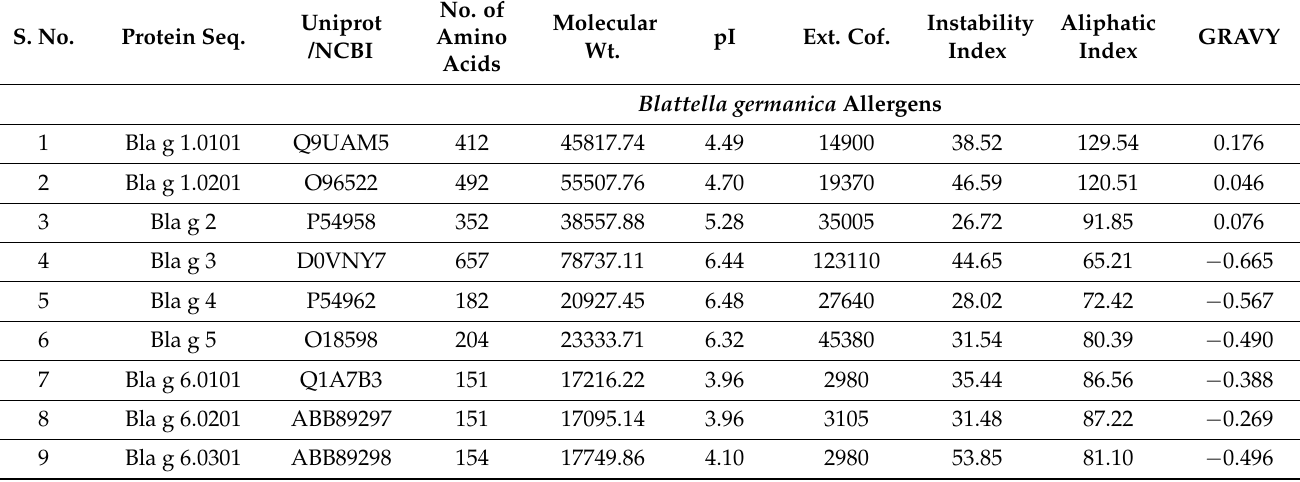
Table 1. Physiochemical characterization of the protein sequences from date palms and